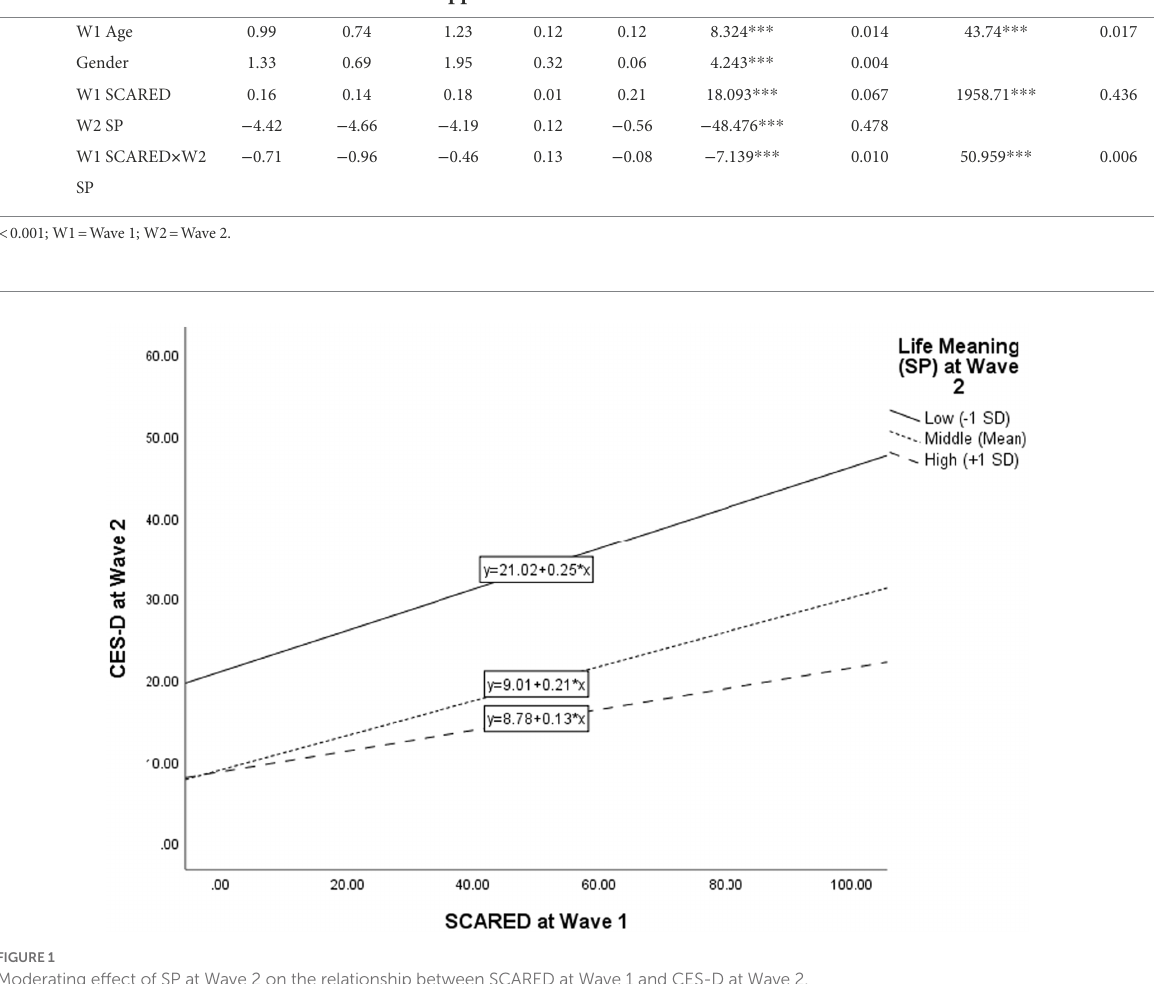
Model Predictor